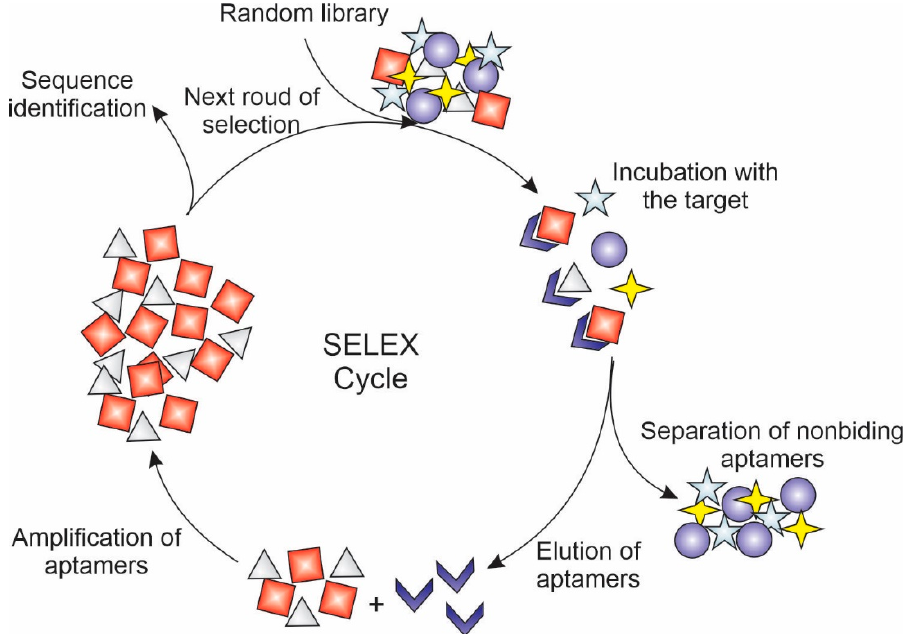
Figure 5. Schematic representation of sequential evolution of ligands by exponential enrichment (SELEX) used to select aptamers with high affinity and specificity by receptors overexpressed in tumor cells.